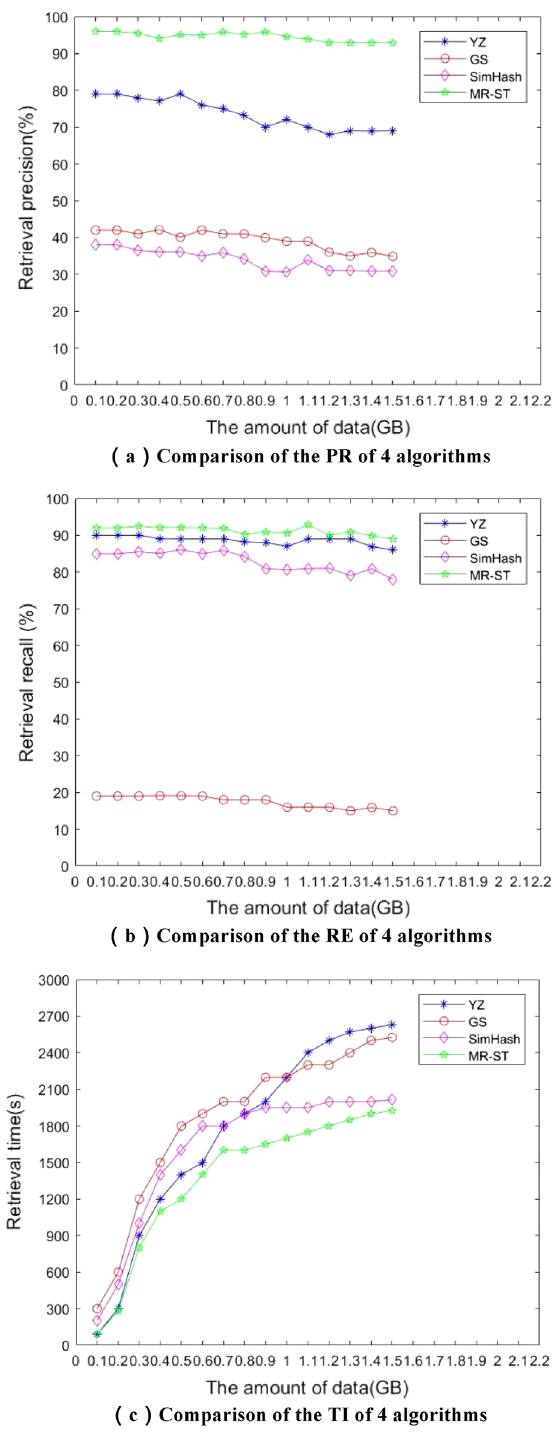
Figure 3. Comparison of retrieval performance of several